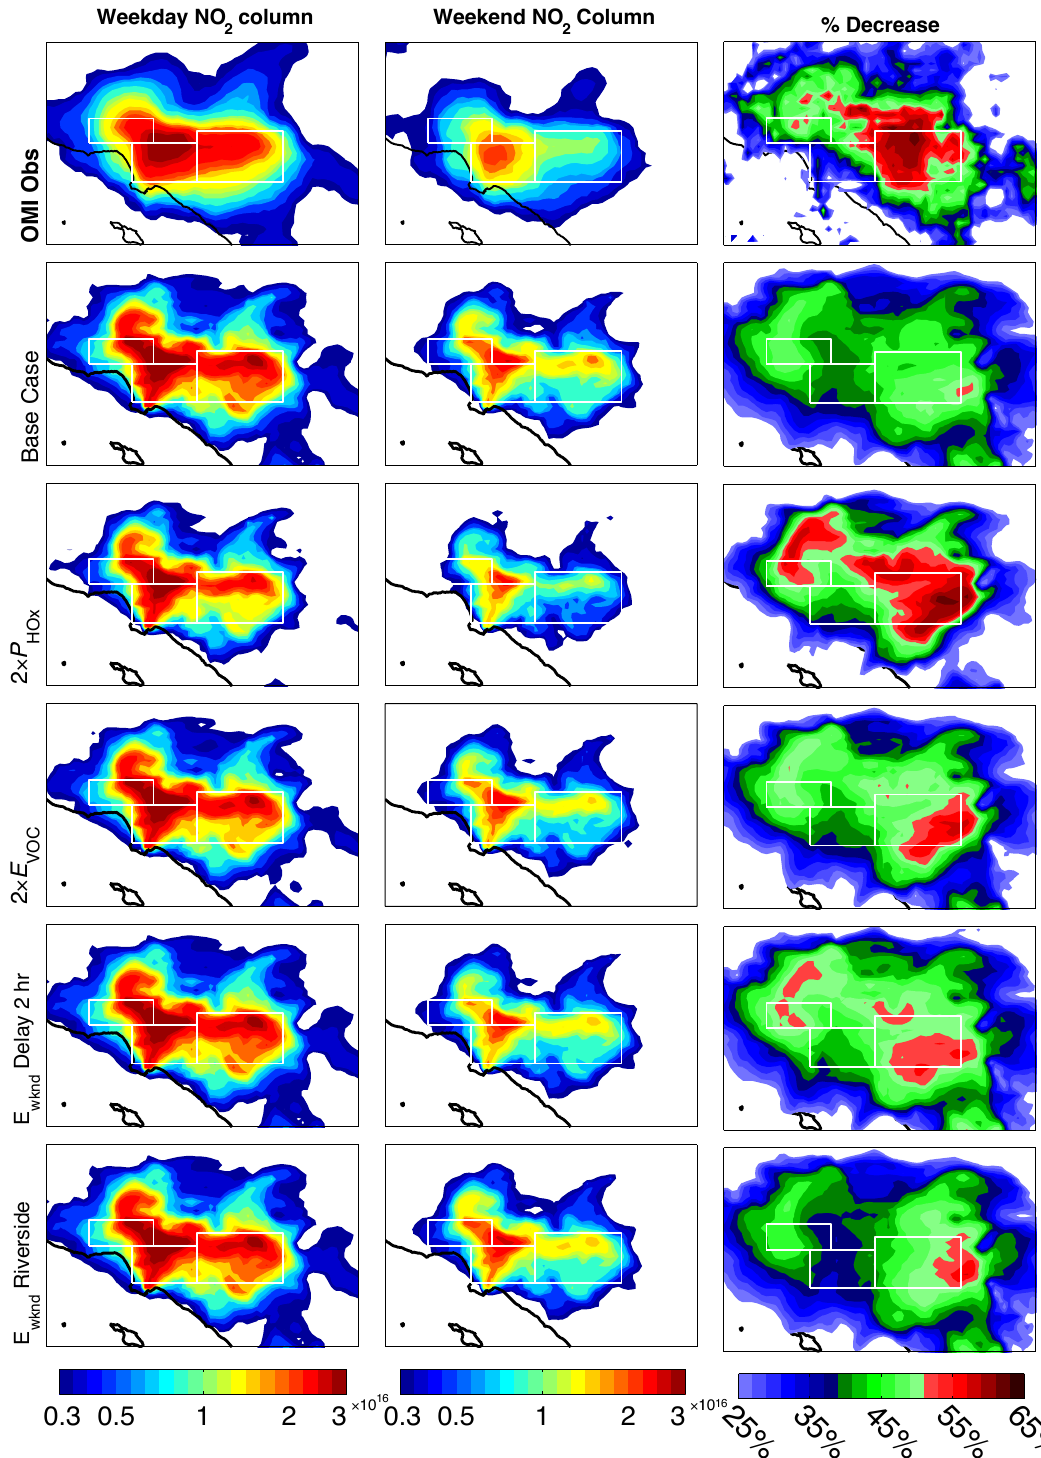
Figure 3. Weekday NO column (molecules cm -2 ), weekend NO column (molecules cm -2 ), and percent change of 2 2 Fig. 3. Weekday NO 2 column (moleculescm − 2 ), weekend NO 2 column (molecules cm − 2 ), and percent change of NO 2 column observed by NO column observed by OMI for May-July 2005-2007 (top row), and simulated with WRF-Chem for 3–14 June 2 OMI for May–July 2005–2007 (top row), and simulated with WRF-Chem for 3–14 June 2008 at 13:00LST using a uniform 37.5% reduction 2008 at 1 p.m. LST using a uniform 37.5% reduction in NO emissions with standard RADM2 chemistry (second x in NO x emissions with standard RADM2 chemistry (second row), a 2 × increase of J O (third row), a 2 × increase of anthropogenic E VOC 3 row), a 2 × increase of J (third row), a 2 × increase of anthropogenic E (fourth row), a two-hour delay of O3 VOC (fourth row), a two-hour delay of anthropogenic weekend E NO and E VOC relative to weekdays (fifth row), and spatially distinct weekend x anthropogenic weekend E and E relative to weekdays (fifth row), and spatially distinct weekend E E NO , and E NO 0.654 × E NO , such reductions (sixth row; weekend E NO 0.525 × E NO NOx VOC NOx x x − San Bernardino x − NEI2005 x − Los Angeles x − NEI2005 reductions (sixth row; Weekend E 0.525 × E , and E 0.654 × E , such that that the domain-average weekend E NO is 0.625 × E NO NOx–San Bernardino NOx-NEI2005 NOx–Los Angeles NOx-NEI2005 x x − NEI2005 the domain-average weekend E is 0.625 × E ). NOx NOx-NEI2005